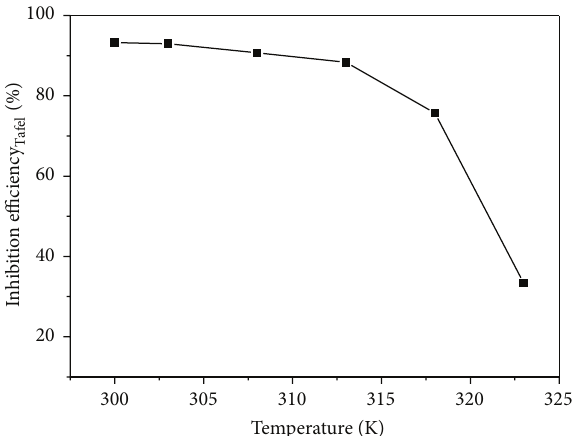
Figure 4: Relationships between inhibition efficiency and temper- ature from potentiodynamic polarization measurements for carbon steel in 0.5 M HCl with 160mg L −1 EAPP.